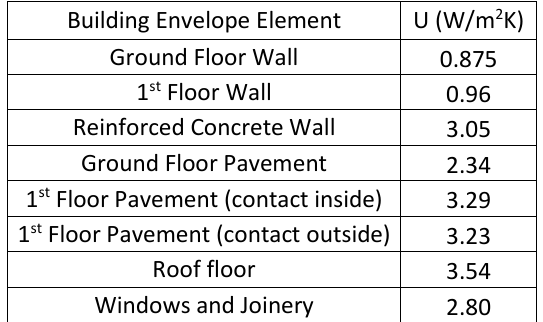
Table 1 Building Envelope Element’s U